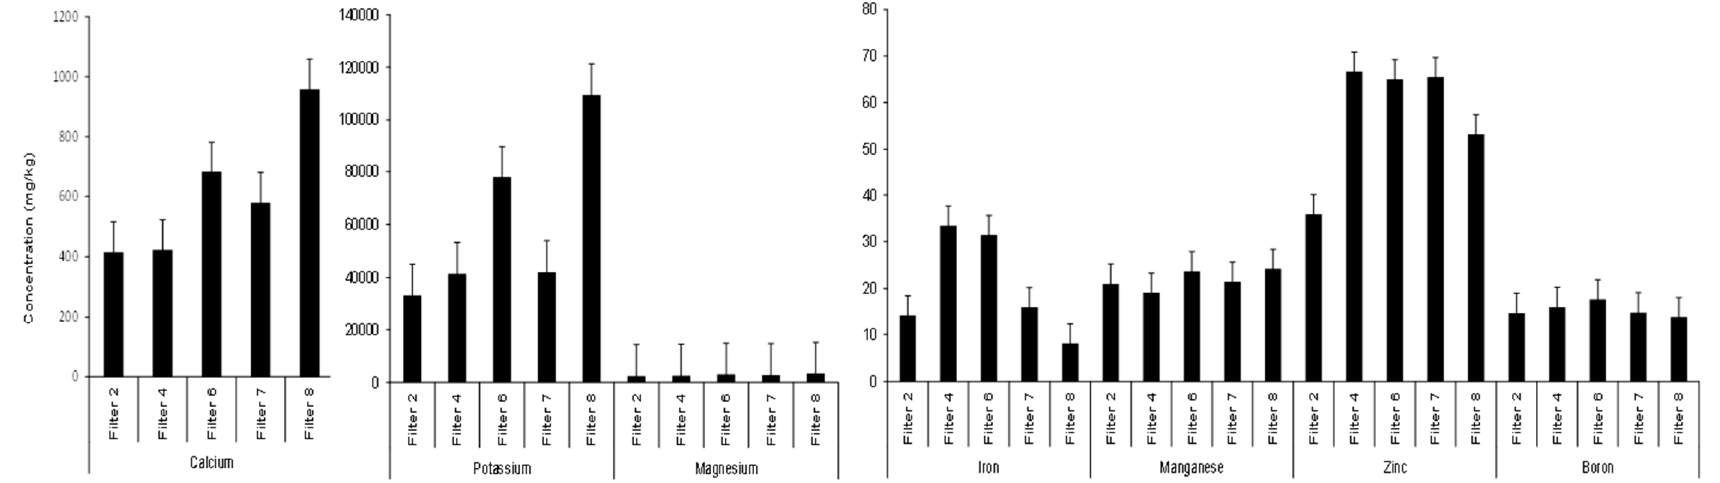
Figure 5 . Elemental analysis within harvested chili daughter generations. Figure 5. Elemental analysis within harvested chili daughter